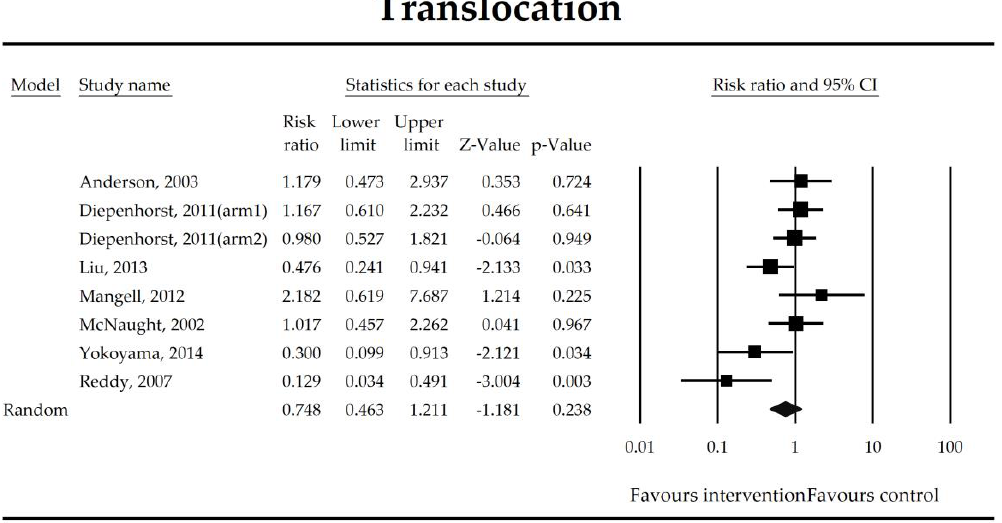
Figure 9. The effect size (risk ratio) for the overall effects of probiotics in the prevention of bacterial translocation.